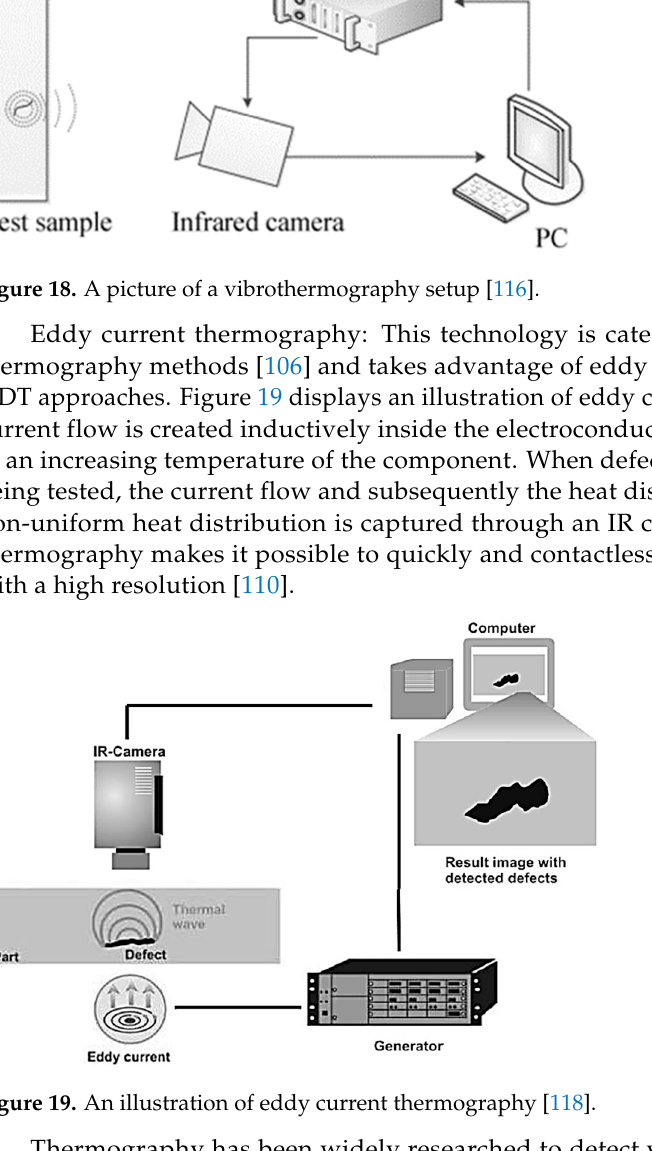
Figure 19. An illustration of eddy current thermography [118].